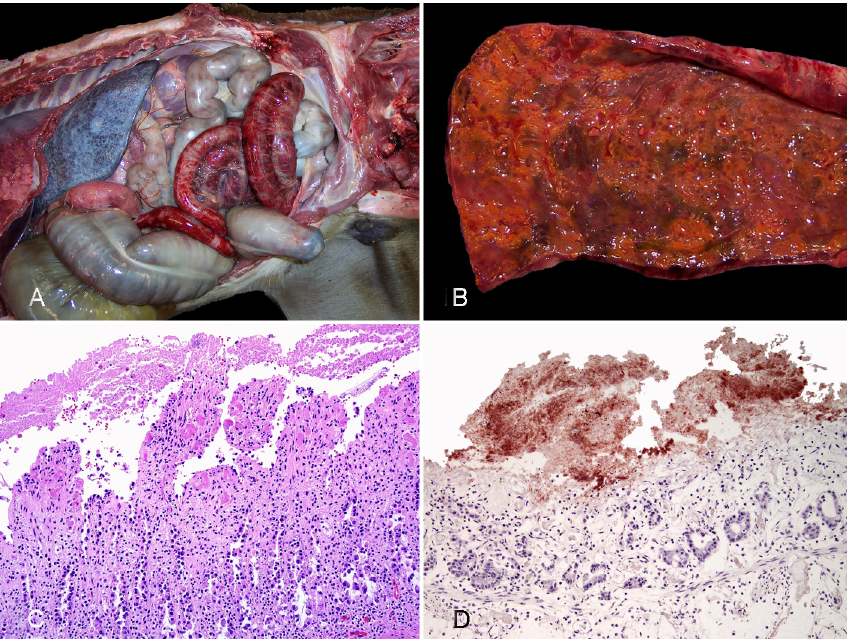
Figure 1. Neonatal foal with enterocolitis produced by Clostridium perfringens type C. ( A ) The serosal view of a large segment of the small intestine is diffusely congested and emorrhagic and the serosa of the large colon and cecum are dark. ( B ) The mucosa of the small intestine is necrotic and covered by an orange pseudomembrane. ( C ) The small intestine shows diffuse mucosal necrosis and multifocal thrombosis (arrowheads); a pseudomembrane (pm) is observed in the lumen; HE. ( D ) Strong positivity for C. perfringens is observed in the superficial mucosa and lumen of the small intestine; C. perfringens IHC. Reprinted with permission from ref. [10]. Copyright 2012 Vet